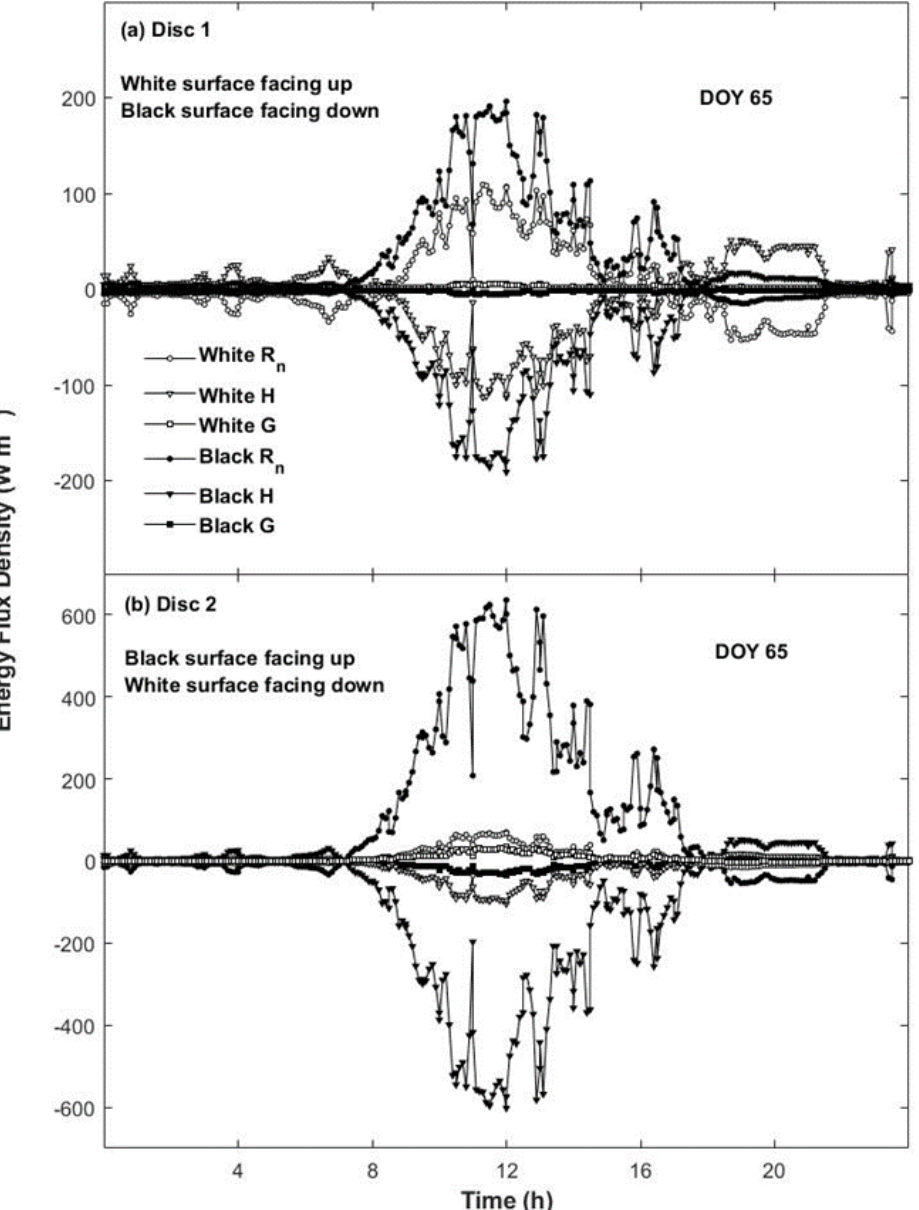
Figure 7. Energy balance components for ( a ) Disc 1 and ( b ) Disc 2 on day of year (DOY) 65. Sign convection dictates that energy fluxes toward the surfaces of the disc are positive and fluxes away from the surfaces are